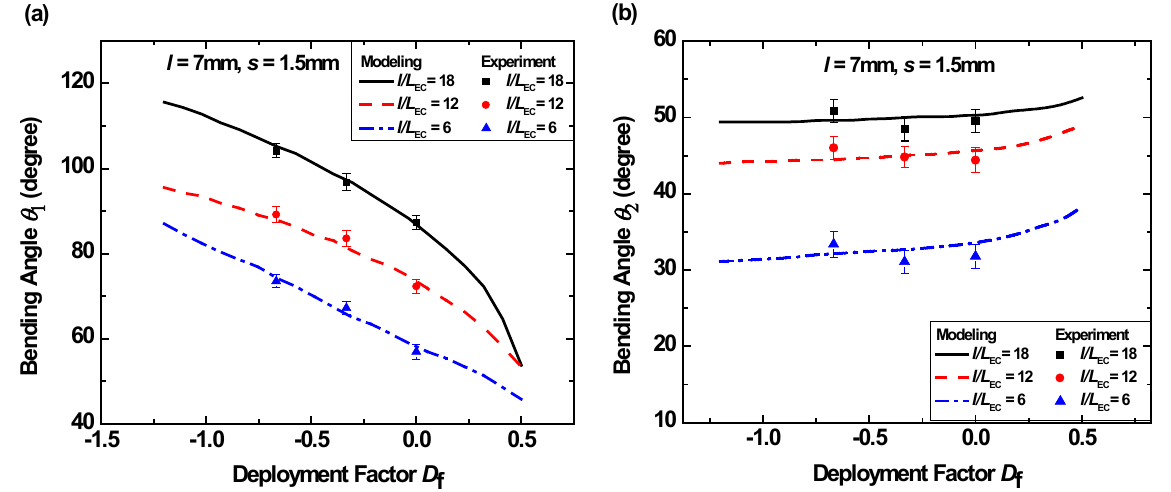
and ( b ) θ as a 1 2